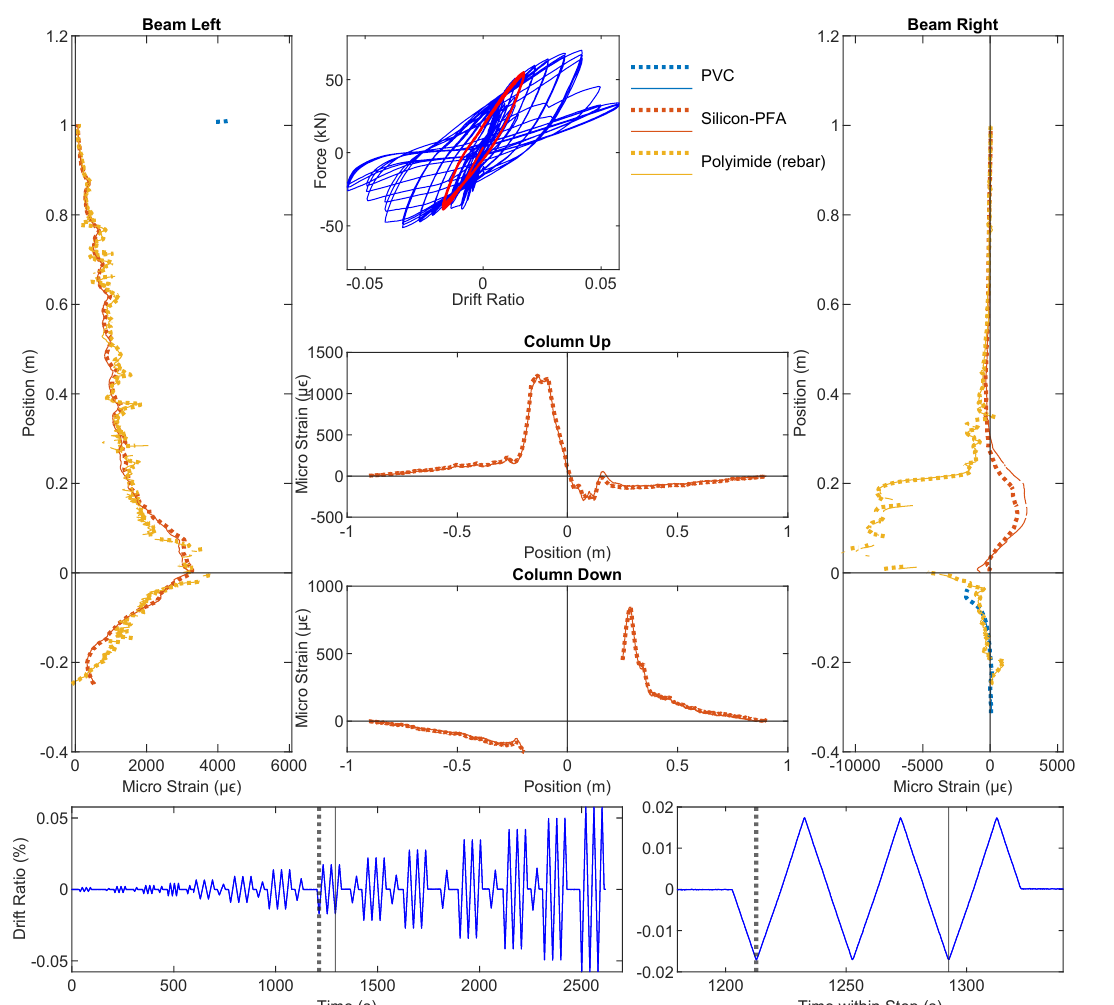
Figure 11. DFOS results at a drift level of −